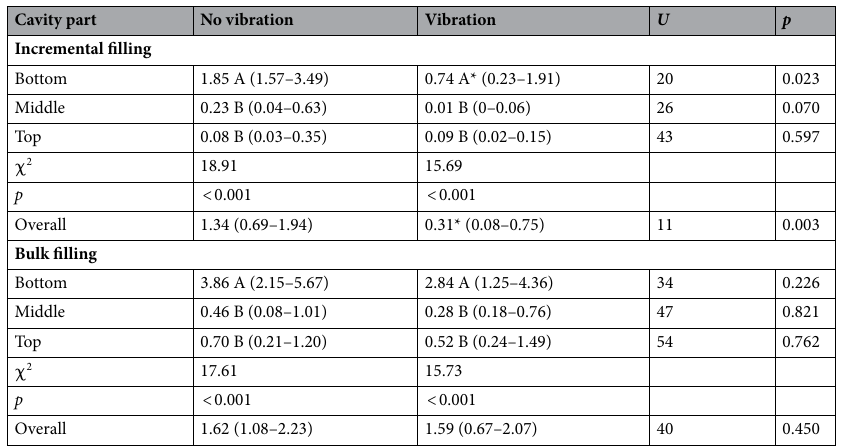
Table 4. Void volume (%) of incremental fillings and bulk fillings in different cavity parts between no vibration and vibration. Interquartile ranges (first quartile, third quartile) are in parentheses. Different uppercase letters indicate statistically significant difference between bottom, middle, and top parts (column) (Kruskal–Wallis and multiple comparisons by Mann–Whitney U tests, p < 0.05). An asterisk